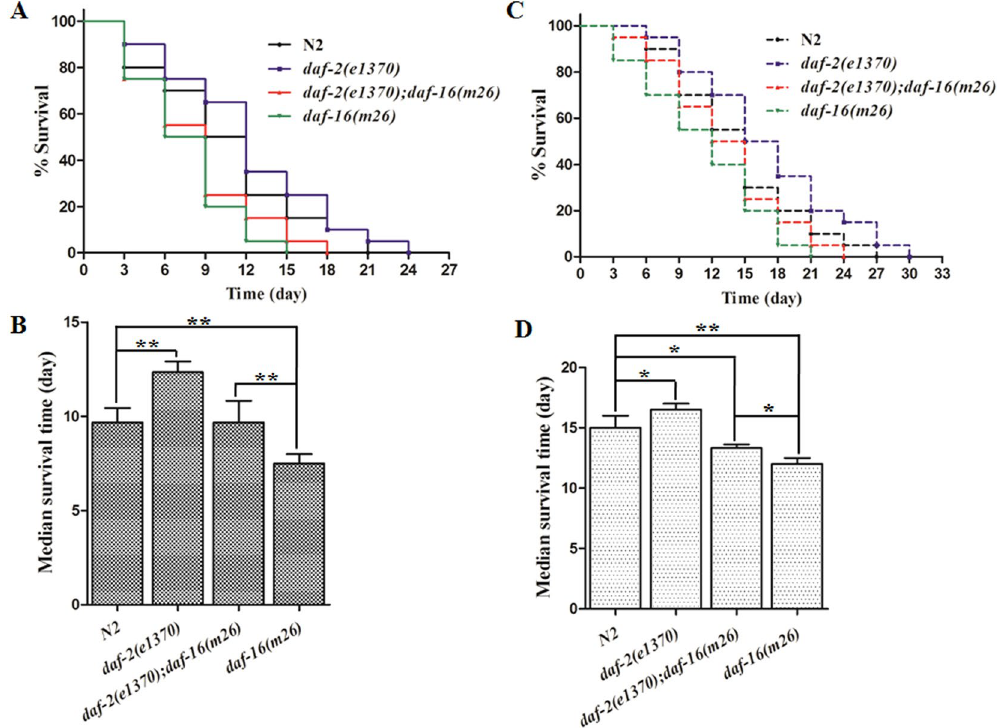
Figure 4. Resistance of C . elegans mutants related to ILR signaling pathway to Cry6Aa2 toxin. ( A ) The representative Kaplan-Meier Survival curves of C . elegans mutants exposed to Cry6Aa2 toxin. ( B ) Comparison of median survival times of C . elegans mutants upon exposure to Cry6Aa2 toxin. ( C ) The representative Kaplan- Meier Survival curves of C . elegans mutants unexposed to toxin. ( D ) Comparison of median survival times of C . elegans mutants without exposure to Cry6Aa2 toxin. The data were plotted using the Kaplan-Meier Survival curves and statistical significance was determined by Log-rank (Mantel-Cox) tests. Each point represents the mean and SD from three replicates. A single asterisk indicates P < 0.05, two asterisks indicate P <